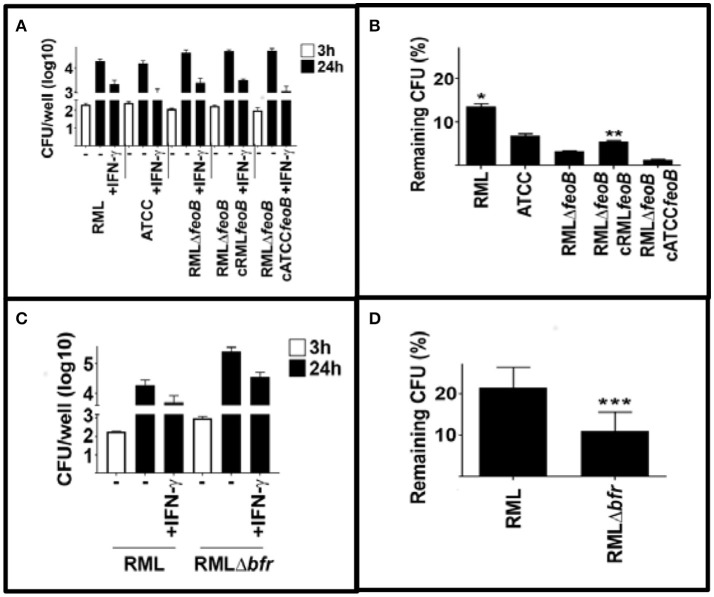
Mutations in iron acquisition enhance sensitivity of LVS to IFN-γ mediated killing. BMM were infected with the indicated strains of LVS and were treated with IFN-γ (10 U/ml) immediately after infection. Three and 24 h after infection intracellular bacteria were enumerated. (A,B) RML LVS is more resistant to IFN-γ mediated killing compared to all other strains tested. Deletion of the feoB gene rendered RML LVS more sensitive to IFN-γ mediated killing and complementation with homologous feoB, but not ATCC feoB partially restored resistance to IFN-γ. (C,D) Deletion of the bacterioferritin (bfr) also increased RML LVS sensitivity to IFN-γ mediated killing. Error bars represent SD. Significance was tested via two-way ANOVA followed by Tukey's multiple comparison of means. Significance was set at p < 0.05. *, significantly greater than all other samples. **, significantly greater than RMLΔfeoB. ***, significantly less than RML LVS. Data is representative of three experiments of similar design.